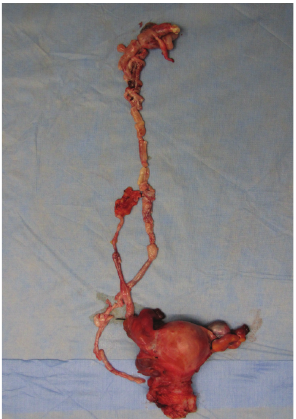
Figure 4: Extirpated uterus, bilateral ovaries and tubes, and tumor in the inferior vena cava extending from both the right uterine vein and common iliac and the right ovarian vein to the inferior vena cava and the right